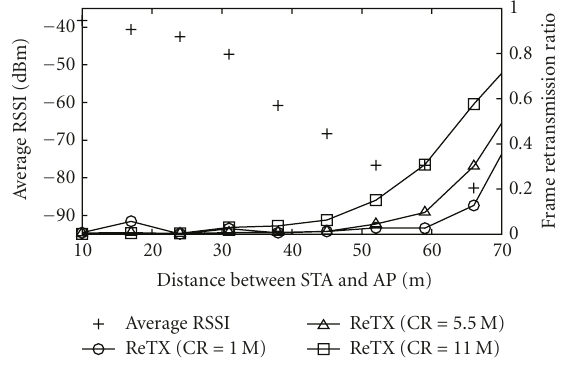
Figure 6: RSSI and frame retransmission ratio.